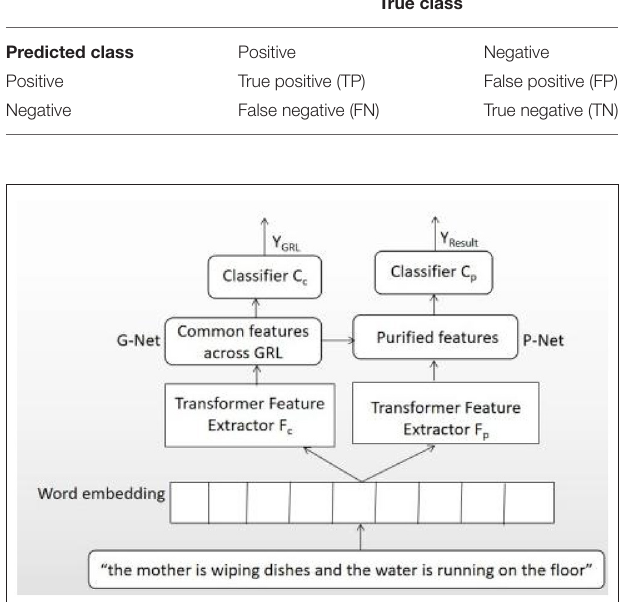
FIGURE 1 | The architecture of